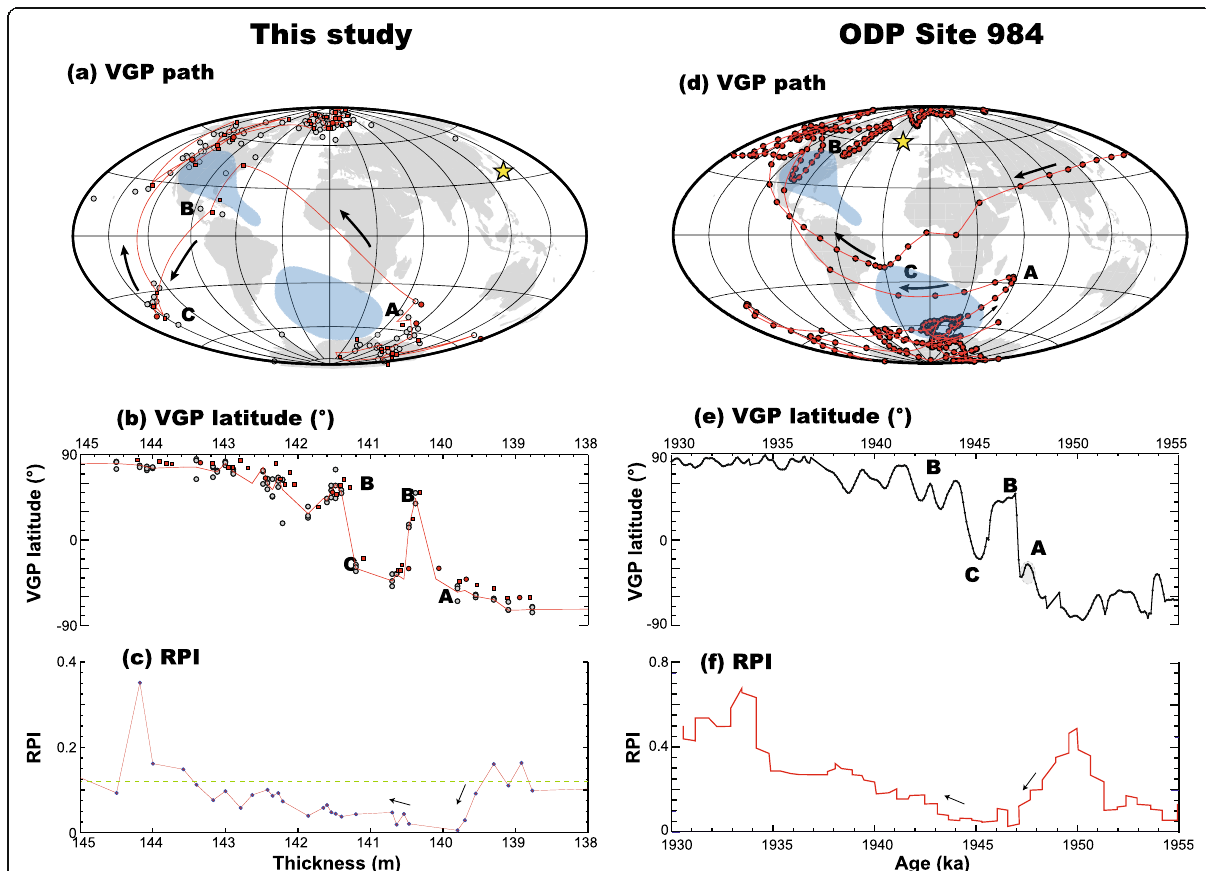
Fig. 9 VGP paths and horizontal plots of the VGP latitude and RPI covering the Olduvai bottom reversal of this study correlated with a North Atlantic record. a – c Show the results of this study. d – f Show the results from ODP Site 984 (Channell et al. 2002, 2013a, 2013b). Letters “ A ” to “ C ” in ( a ) and ( b ) and ( d ) and ( e ) indicate the locations of the characteristic VGP clusters identified on ( a ) and ( d ), respectively. The blue shaded areas in ( a ) and ( d ) indicate that the vertical component of the NAD field at the Earth ’ s surface is less than − 15 μ T (Constable 2007). The yellow stars indicate the sample/core sites. The green dashed line in ( c ) indicates the average RPI value for the entire interval of this study. The red square shows the site mean value at a site in ( a ) and ( b ) if multiple ChRMs are available at a site. The grey circle in ( a ) and ( b ) shows a single value used to deduce a site-mean value, while the red circle in ( a ) and ( b ) shows a representative value at a site if a single ChRM is only available at a site. The lines are connected among the red squares or the red